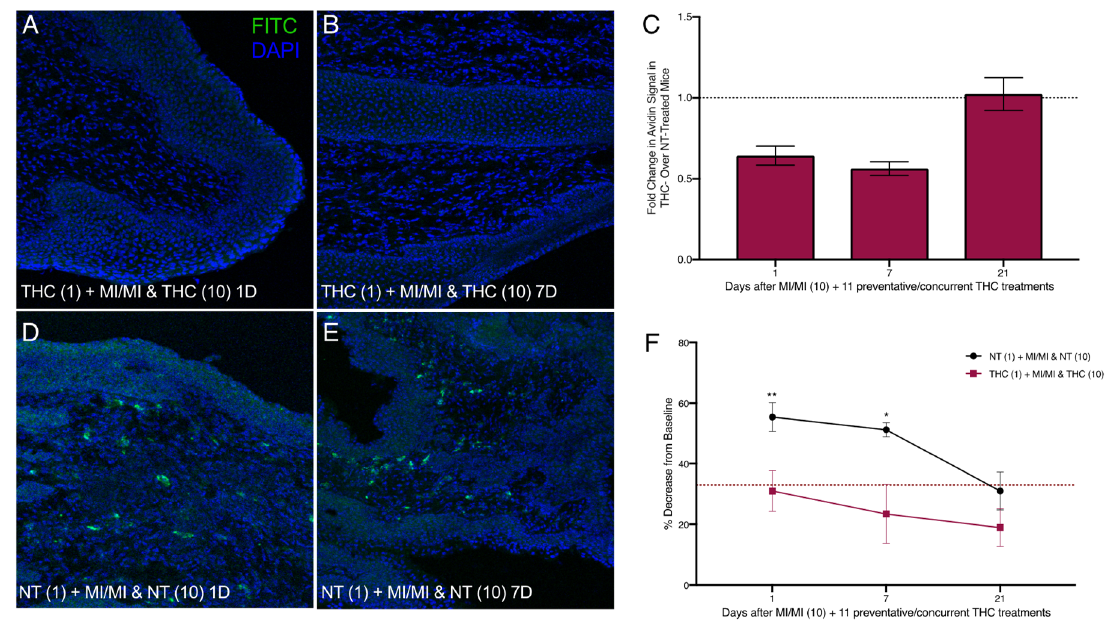
Figure 6. Reduced vaginal mast cell density and ano-genital sensitivity following intra-vaginal preventive THC treatments before and during 10 vaginal MI challenges in previously sensitized ND4 female mice. ( A , B , D , E ) Representative images of vaginal canal tissue from THC-treated ( A , B ) and NT ( D , E ) MI-challenged mice one and seven days after the 10th MI challenge. Mast cells stained with FITC-conjugated avidin (green) and nuclei counterstained with DAPI (blue); 200 × magnification. ( C ) Mast cell density displayed as fold change in avidin + signal intensity of the THC-treated over NT mice; n = 3–7 mice / treatment group. ( F ) Ano-genital tactile sensitivity of preventive THC-treated and NT mice at 1, 7, and 21 days after the 10th MI challenge; 8–9 mice / treatment group. Red dotted line denotes 33% hyperalgesia threshold. Results displayed as mean ± SEM. Significance with respect to control group * p < 0.05 and ** p < 0.01.